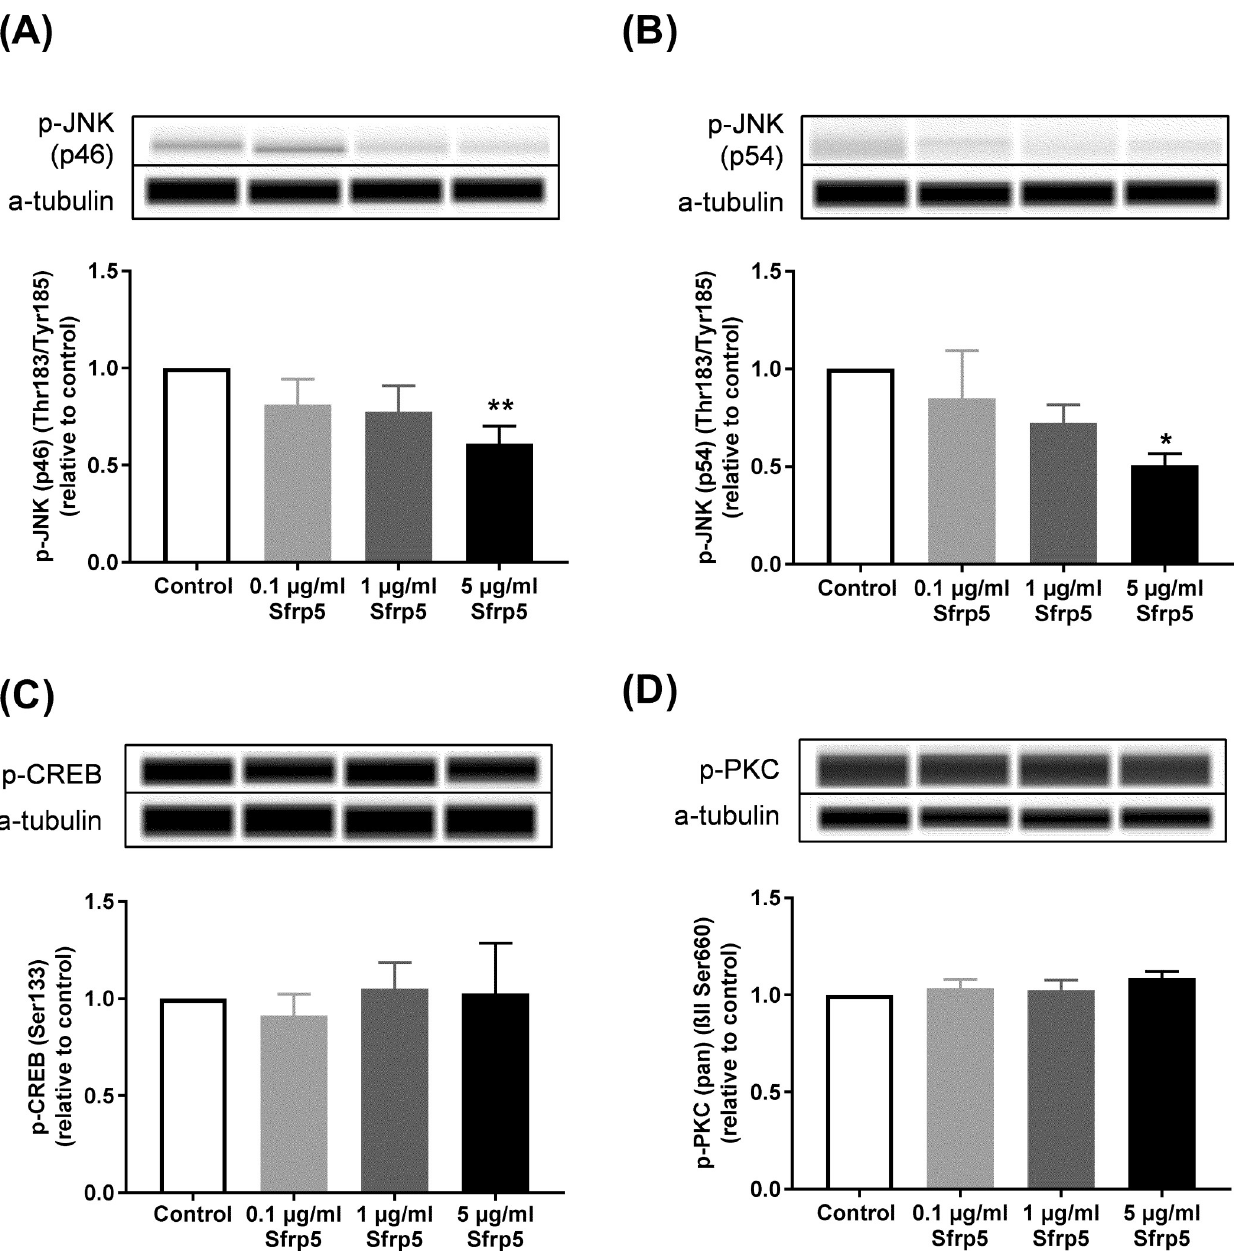
Fig 4. Sfrp5 and non-canonical Wnt signalling pathway. Effect of different concentrations of Sfrp5 on phosphorylation levels of markers of the non- canonical Wnt-signalling pathway: (A) c-Jun N-terminal kinases (JNK) (p46) (46 kDa) (N = 5), (B) JNK (p54) (54 kDa) (N = 5) (C) cAMP response element-binding protein (CREB) (43 kDa) (N = 5) and (D) protein kinase C (PKC) α , β I, β II, δ , ε , η and θ isoforms (78, 80, 82 and 85 kDa) (N = 5) in INS- 1E cells. The loading control was α -tubulin (52 kDa). Data are presented as mean + SEM (fold change relative to control). � , p < 0.05; �� , p < 0.01 vs. control.